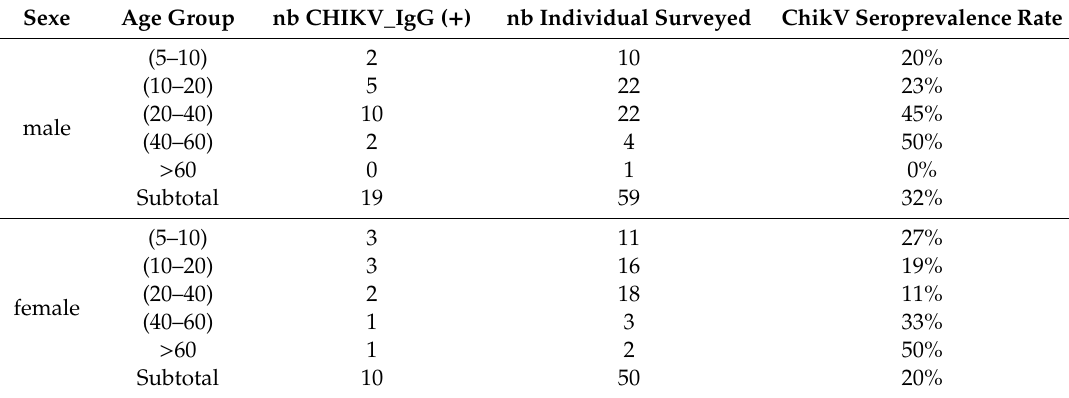
Table A3. CHIKV seroprevalence by sex and age group in villages where population density was > 400 people per km 2